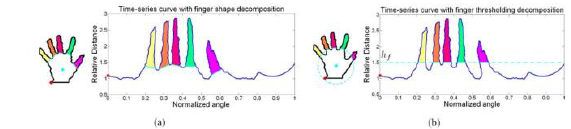
Figure 1. Hand gesture recognition (Ren, et al., 2013)